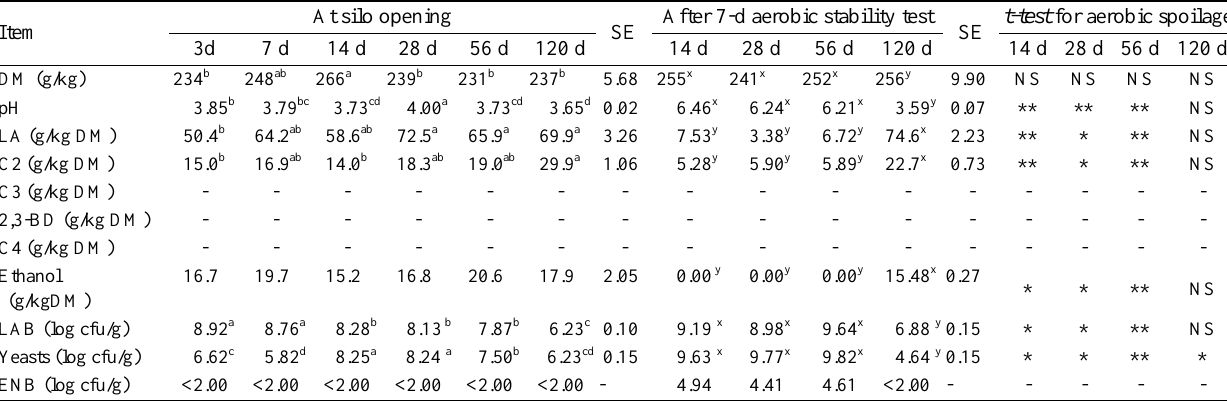
Silos were opened after 3, 7, 14, 28, 56, and 120 d, and a 7-day aerobic stability test was conducted for the silages from the latter 4 silages. Values with different letters ( a-b, x-y ) within a column are significantly different from one another. NS, p  0.05; * p<0.05; ** p<0.01. DM = Dry matter; LA = Lactic acid; C2 = Acetic acid; C3 = Propionic acid; 2,3-BD = 2,3-butanediol; C4 = Butyric acid; LAB = Lactic acid bacteria; ENB = Enterobacteria.